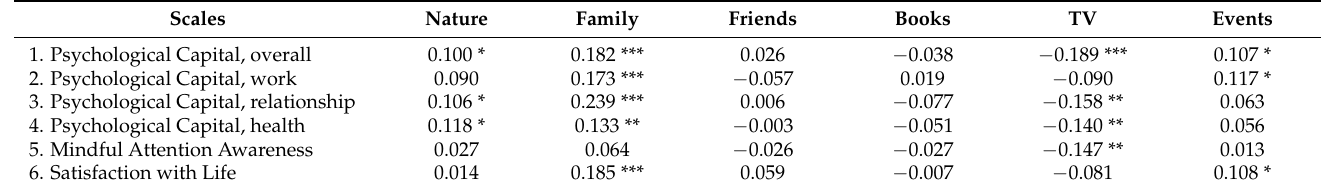
Table 7. Bivariate correlations between types of leisure preferences and the PCQ-12, the MAAS, and the SWLS.